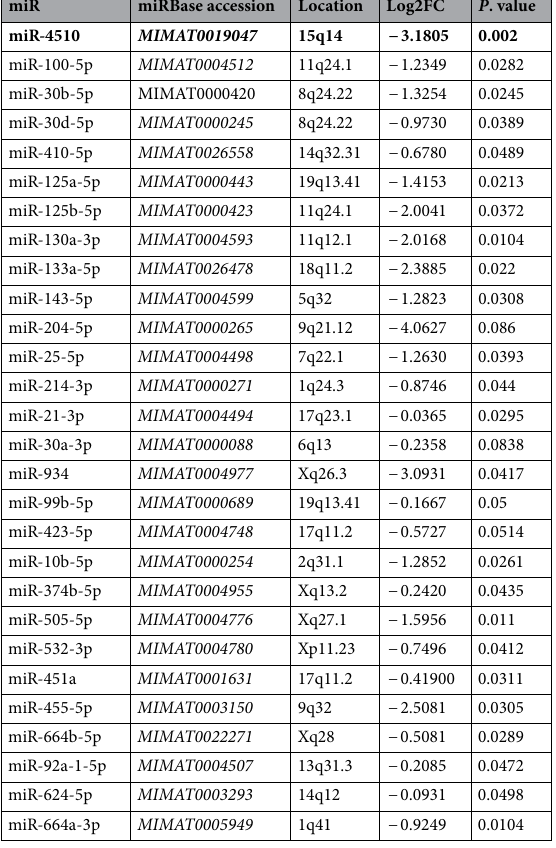
Table 2. Marked down-regulated microRNAs in BC compared with NAT. Significant values are in